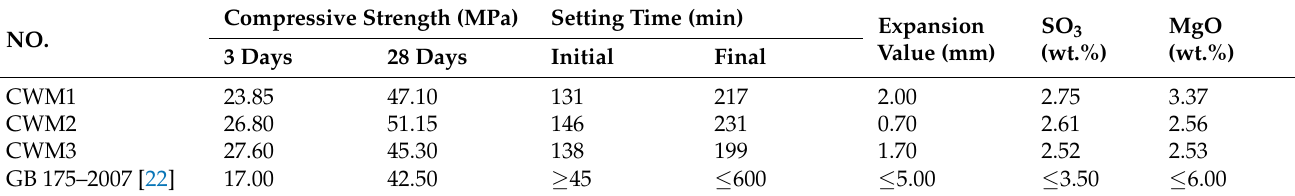
Table 3. Index parameter of CWM (water/cement ratio of 0.37).